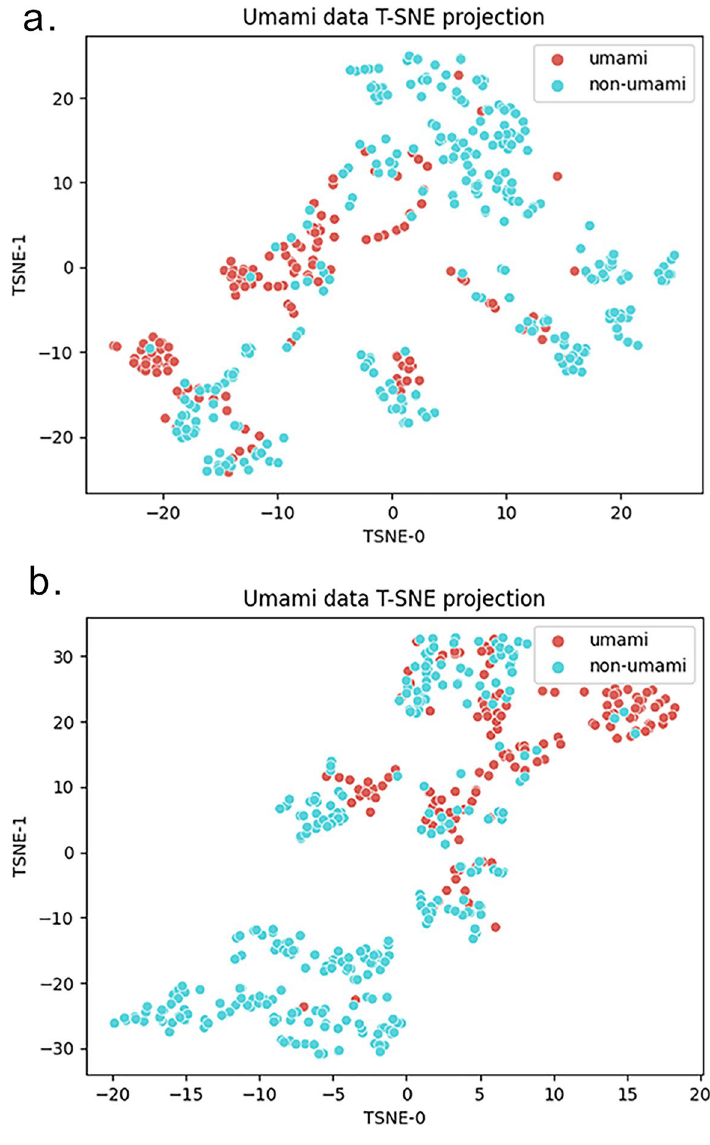
Figure 3. A tSNE applied to the umami and non-umami samples for the whole dataset taking into account ( a ) all molecular descriptors (1613 features) and ( b ) the best 12 selected descriptors derived from the feature selection process. The selected feature subset ( b ) results in a remarkably better ability in discriminating between umami and non-umami